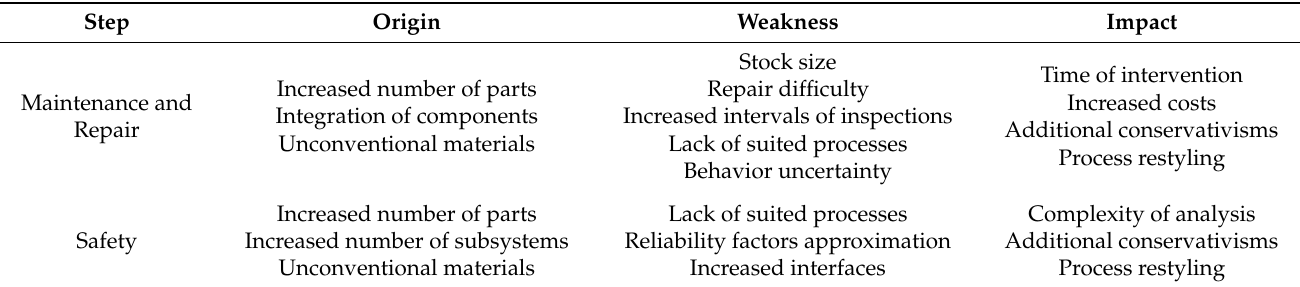
Table 4. Summary of weakness and criticalities of a morphing system—operations and